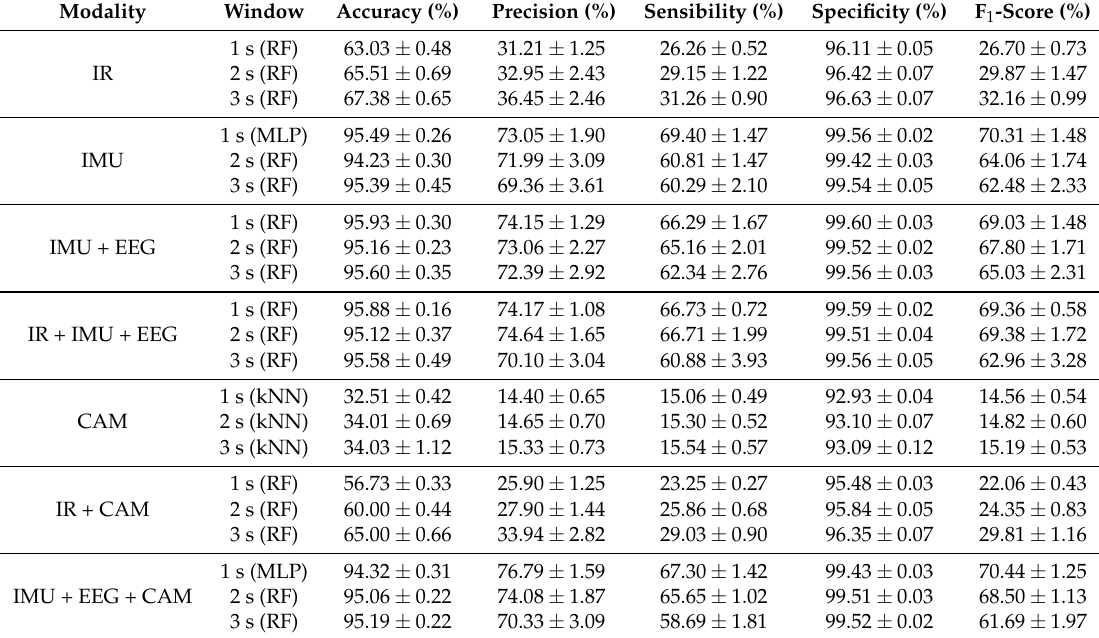
Table 13. The best performance (mean ± standard deviation) obtained for each modality, based on the F 1 -score, depending on the window size. The best model is written in